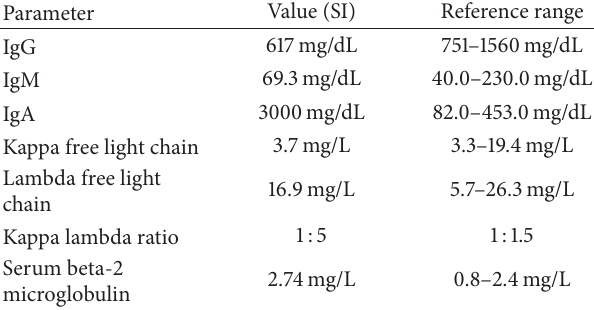
Figure 1: A diffuse extraoral swelling in the middle and lower one- third of the face.